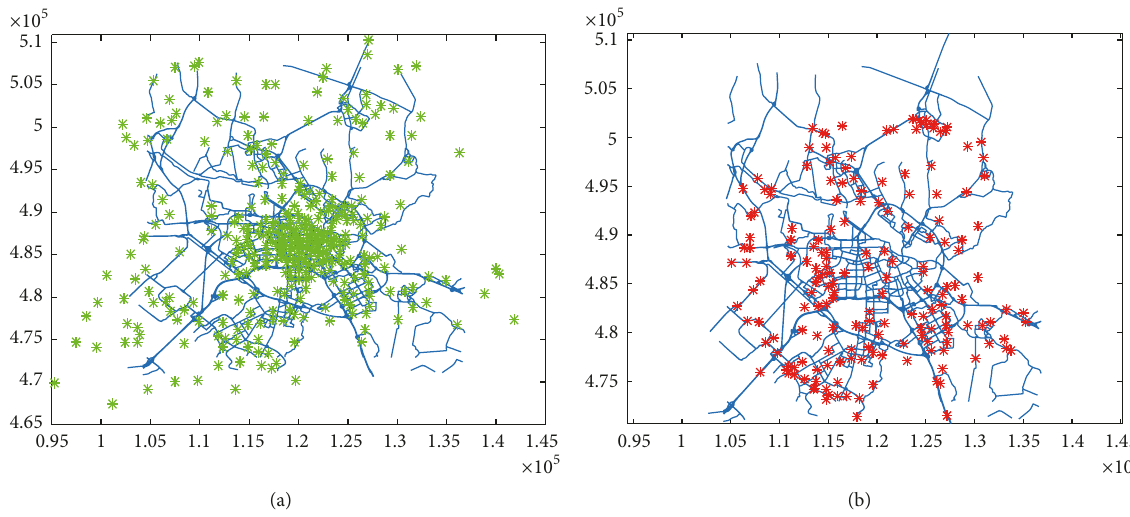
Figure 3: Zone aggregation in the network, (a) 350 zones before aggregation and (b) 183 zones after aggregation.